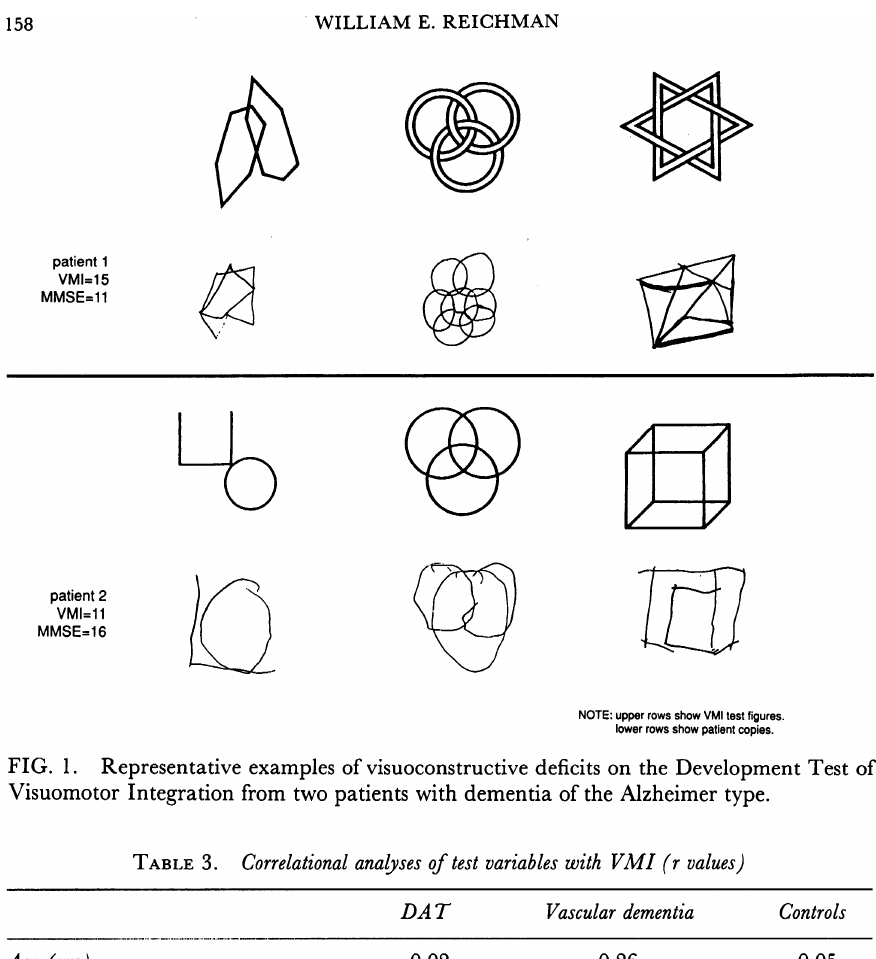
TABLE 3. Correlational analyses of test variables with V M I (r values) DAT Vascular dementia